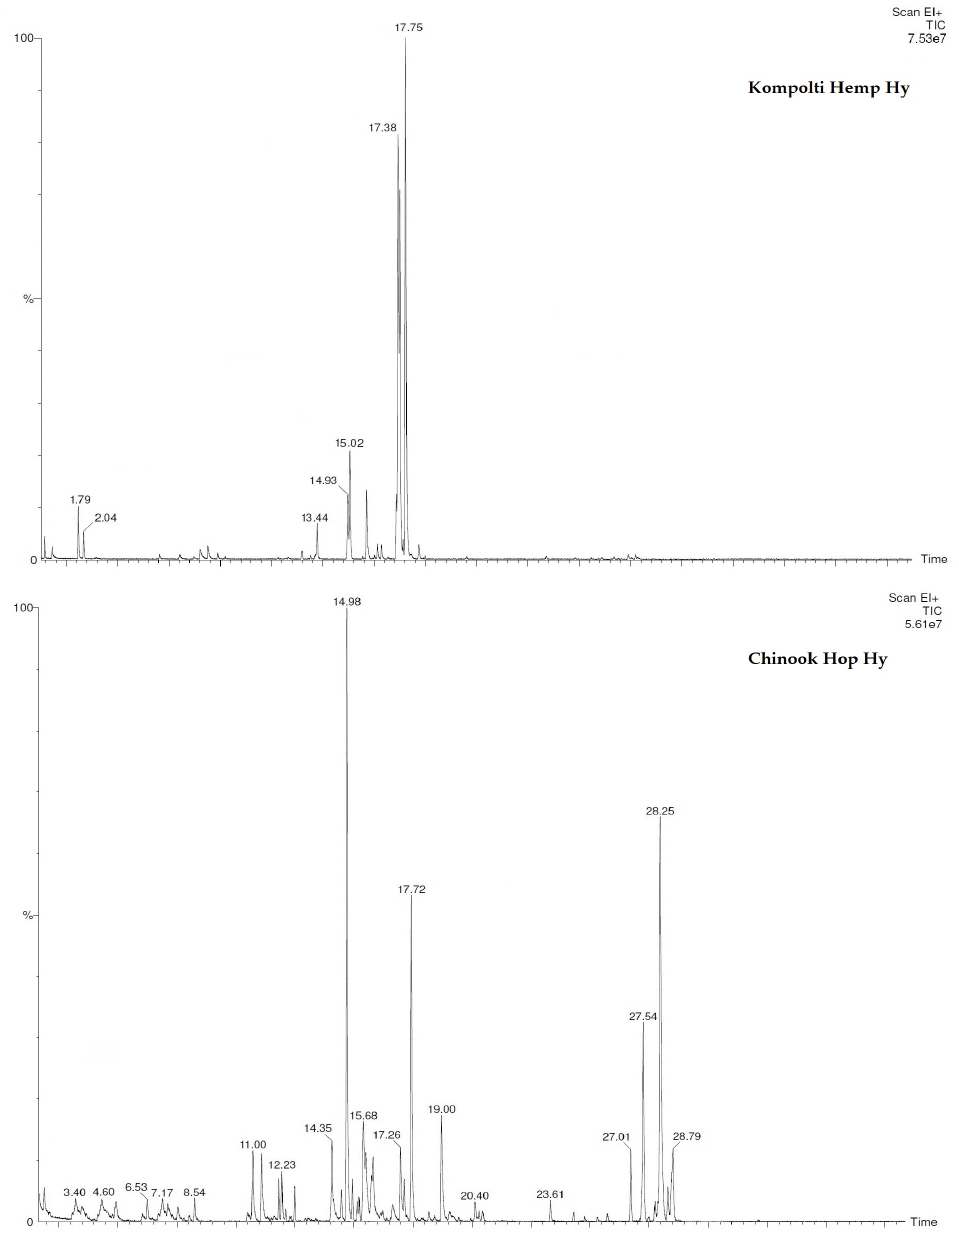
Figure 2. Chromatograms of hemp and hop Hys.